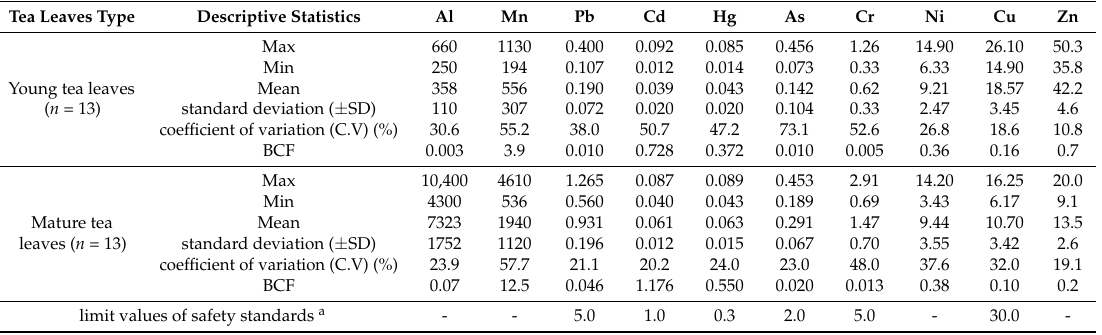
Table 3. Concentration (mg · kg − 1 ) of heavy metals and Al in young and mature tea leaves collected from Puan tea planting area, Guizhou Province, China ( n =